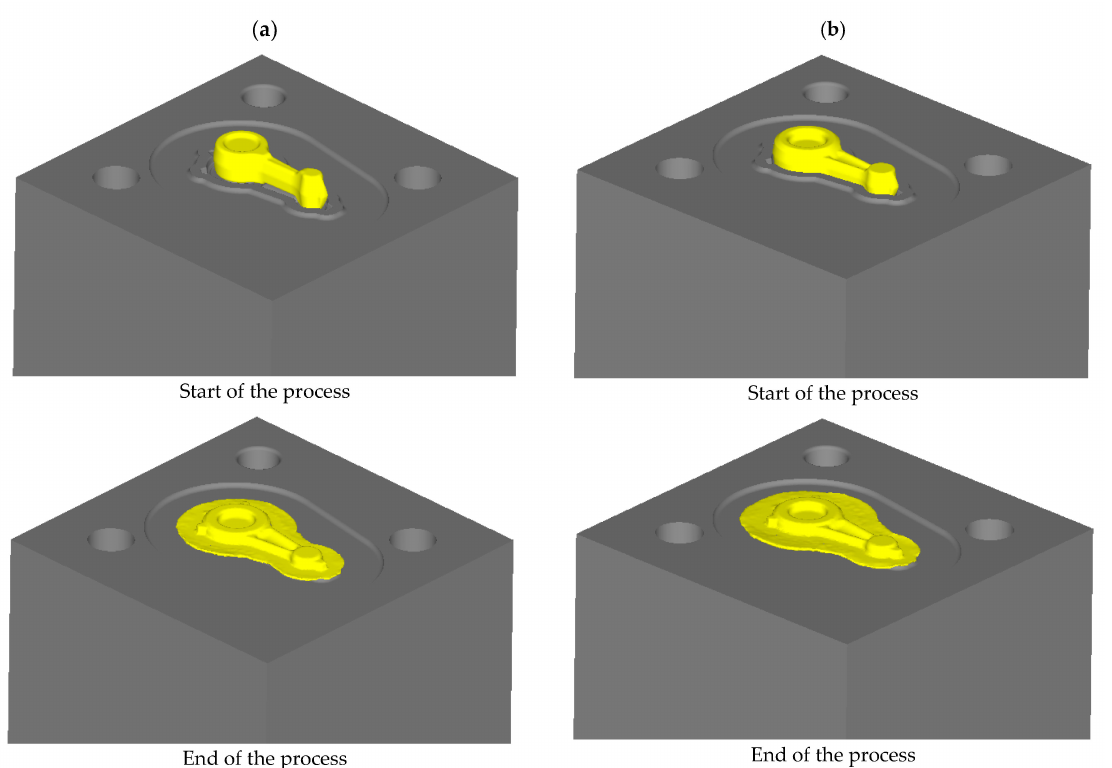
Figure 17. Scheme of the forging process of the connecting rod forging from the preform according to variants: ( a ) 1; ( b ) 2 (top tool was removed to facilitate the illustration of the process).